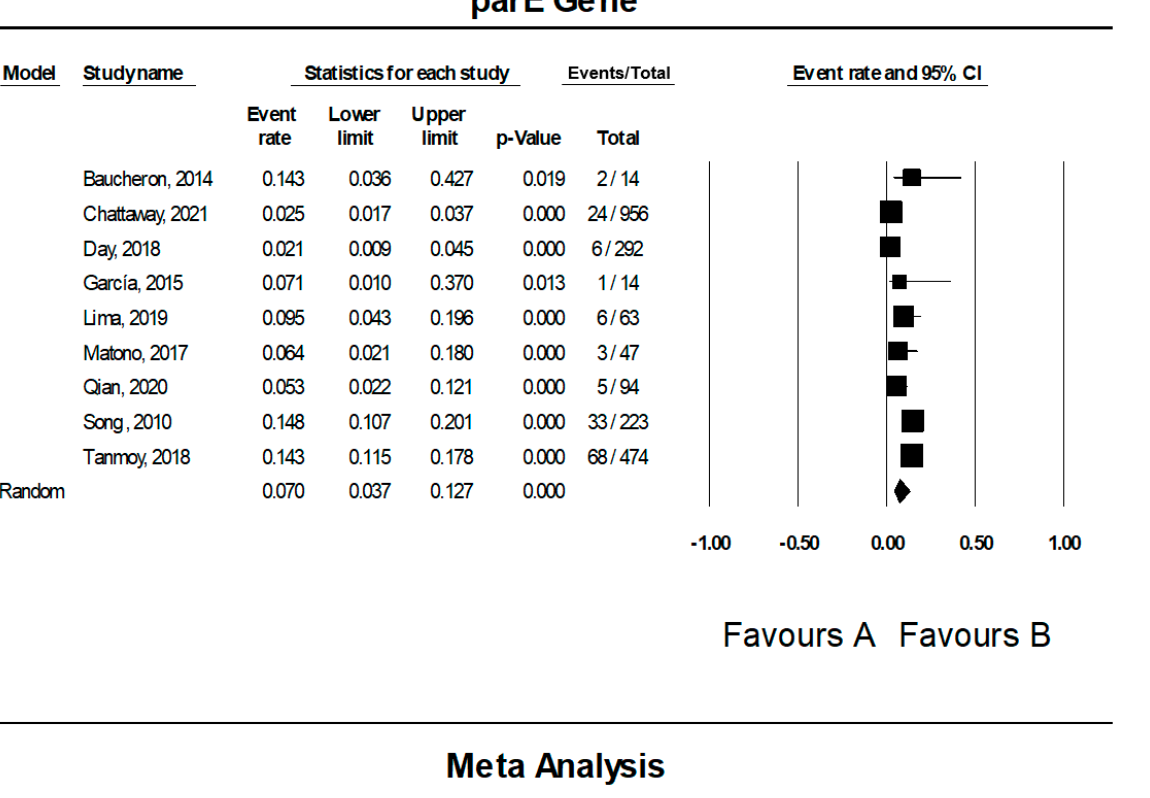
Figure 11. Forest plot showing the pooled prevalence of parE gene in resistant S. Typhi isolates estimated by a random effect model of meta-analysis. (7.0%, I 2 : 90.47, 95% CI: 3.7–12.7, p -value < 0.001) [22,24,26,31,36,38,42,48,49]. Table 6. Sub-group analysis of prevalence parE gene in S. Typhi according to regions.